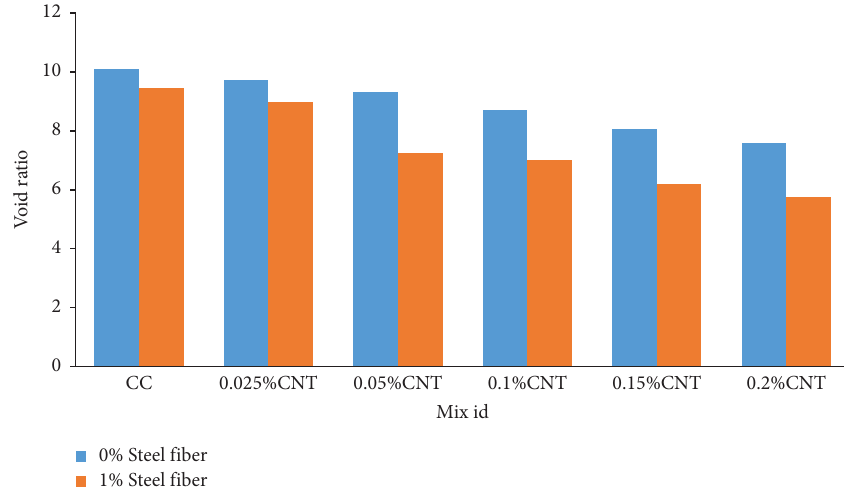
Figure 16: Void ratio for specimens with and without steel